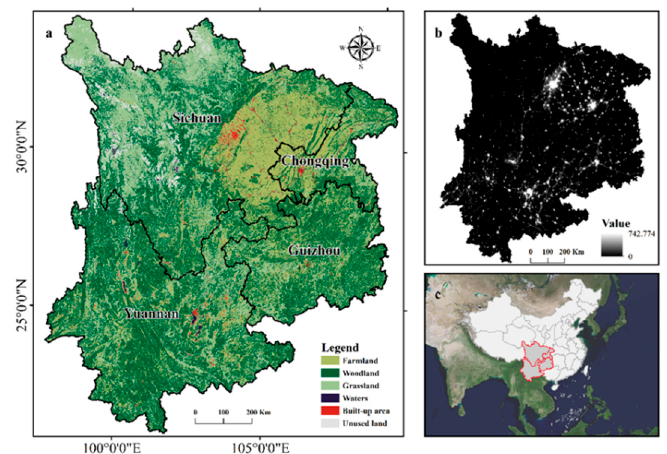
Figure 1. Study area of four southwestern provinces in China: ( a ) Land use patterns; ( b ) night-time light imagery in 2010; and ( c ) location of the study area in China.